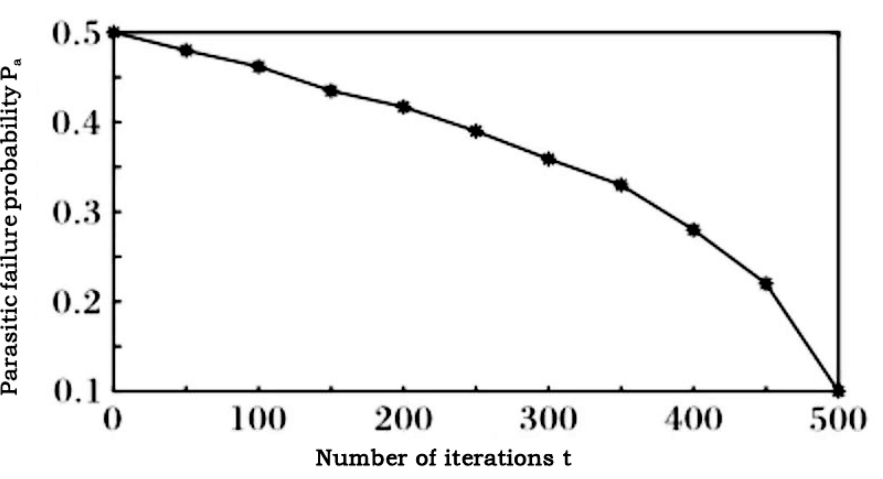
Figure 5. The curve of Pa varies with number of